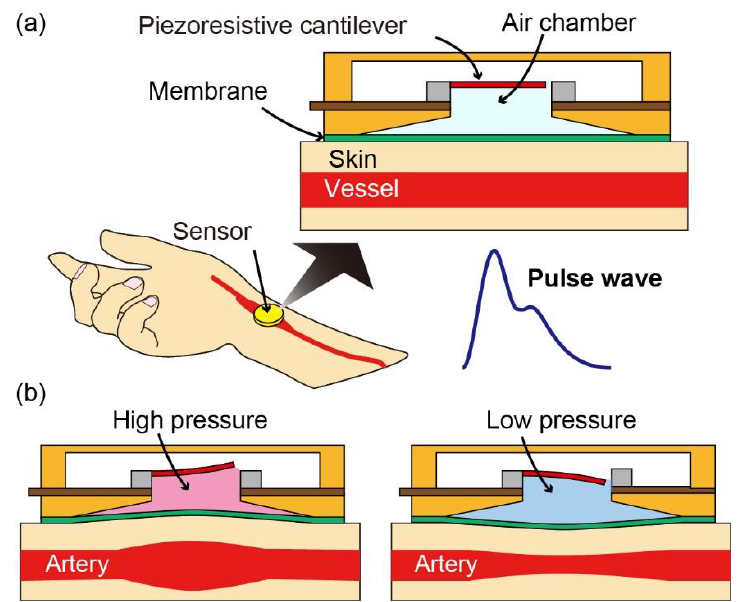
Figure 1. ( a ) Conceptual schematic diagram of the proposed sensor to measure pulse wave. The proposed sensor consists of a piezoresistive cantilever and a chamber covered with a soft membrane. ( b ) Sensing principle of the proposed sensor.